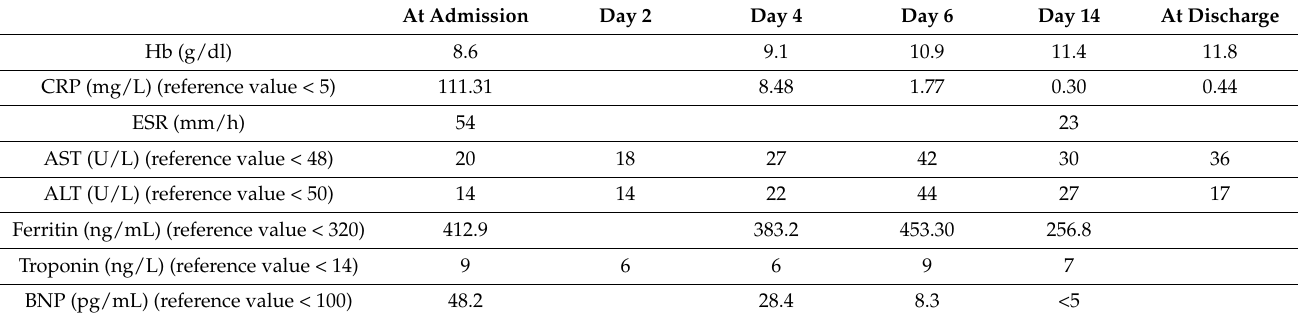
Table 1. Laboratory findings during hospital